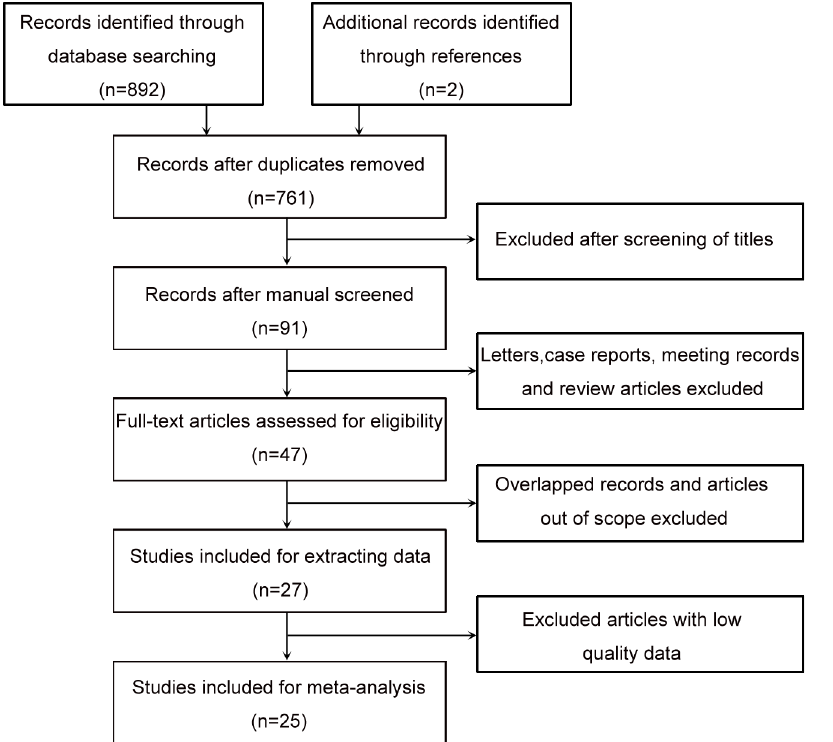
Fig 1. Flowchart of selecting studies for inclusion in this